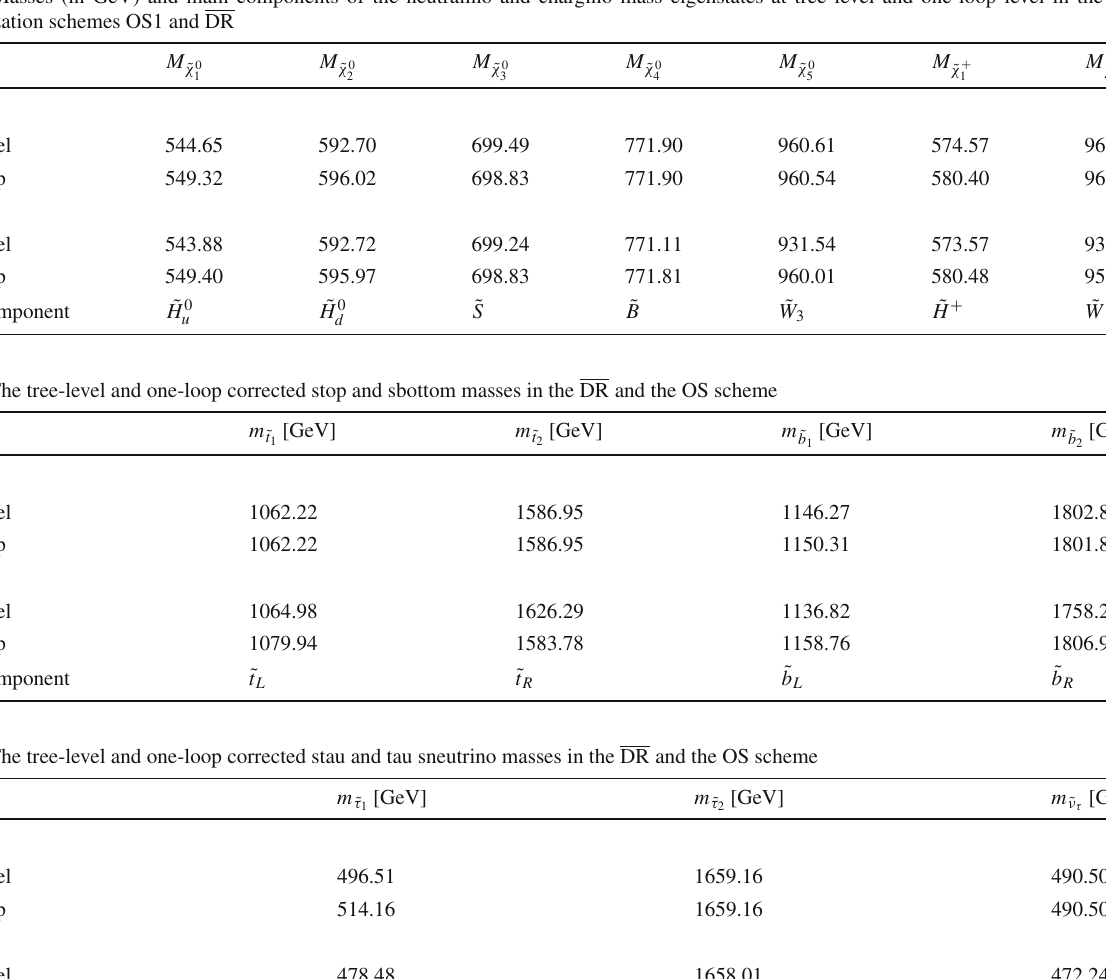
Table 2 Masses (in GeV) and main components of the neutralino and chargino mass eigenstates at tree level and one-loop level in the two renormalization schemes OS1 and DR